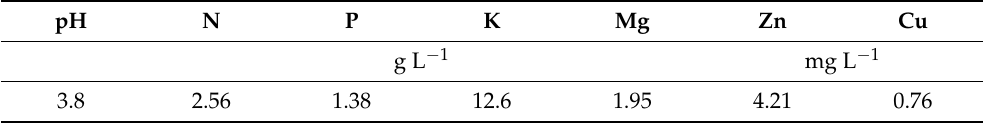
Table 1. Characteristics of distillery